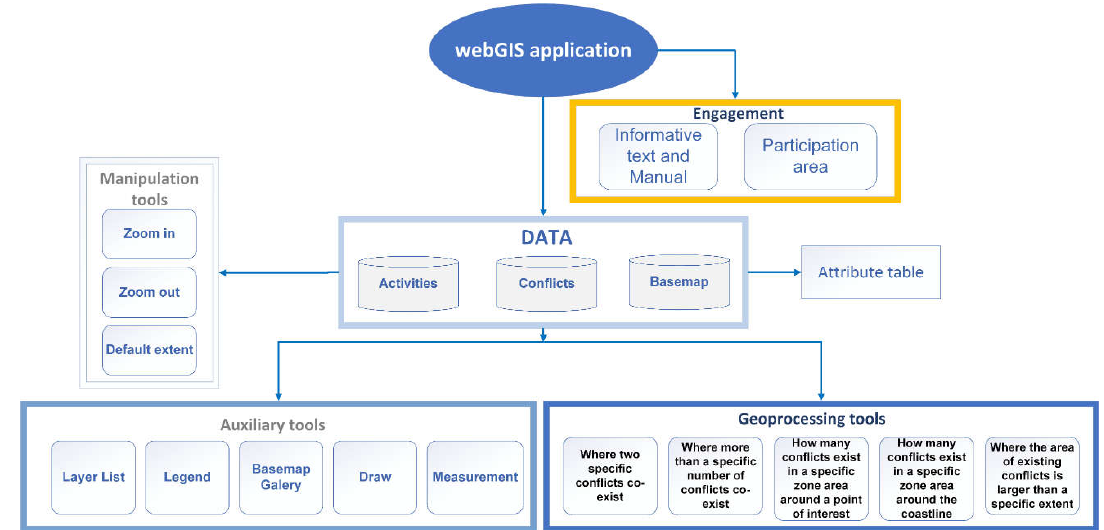
Figure 2. The architecture of the webGIS application and the available geoprocessing tools (https://sdi-portal.aegean.gr/portal/apps/sites/#/conflicts-assessment (accessed on 5 March 2022).